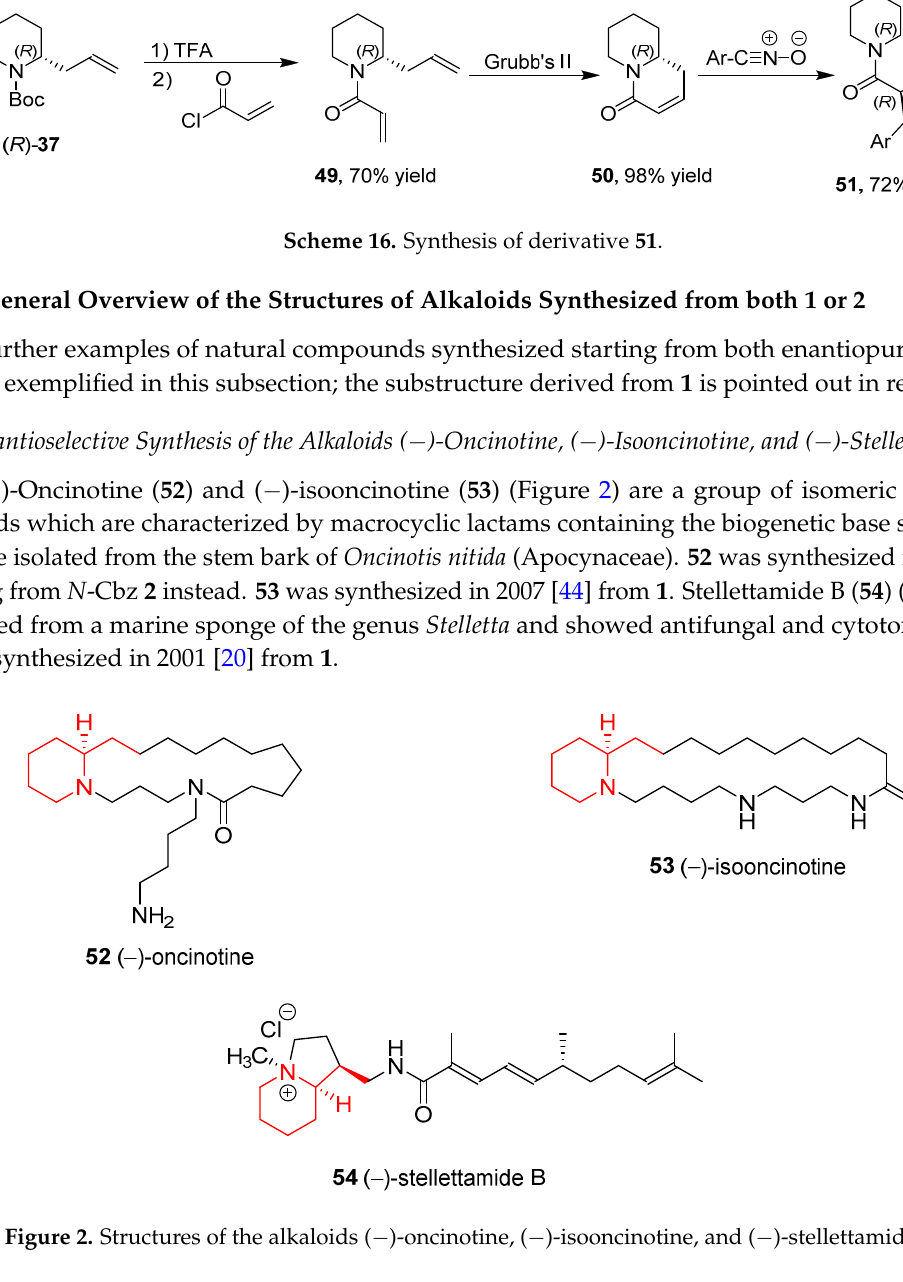
Figure 2. Structures of the alkaloids ( − )-oncinotine, ( − )-isooncinotine, and ( − )-stellettamide B.